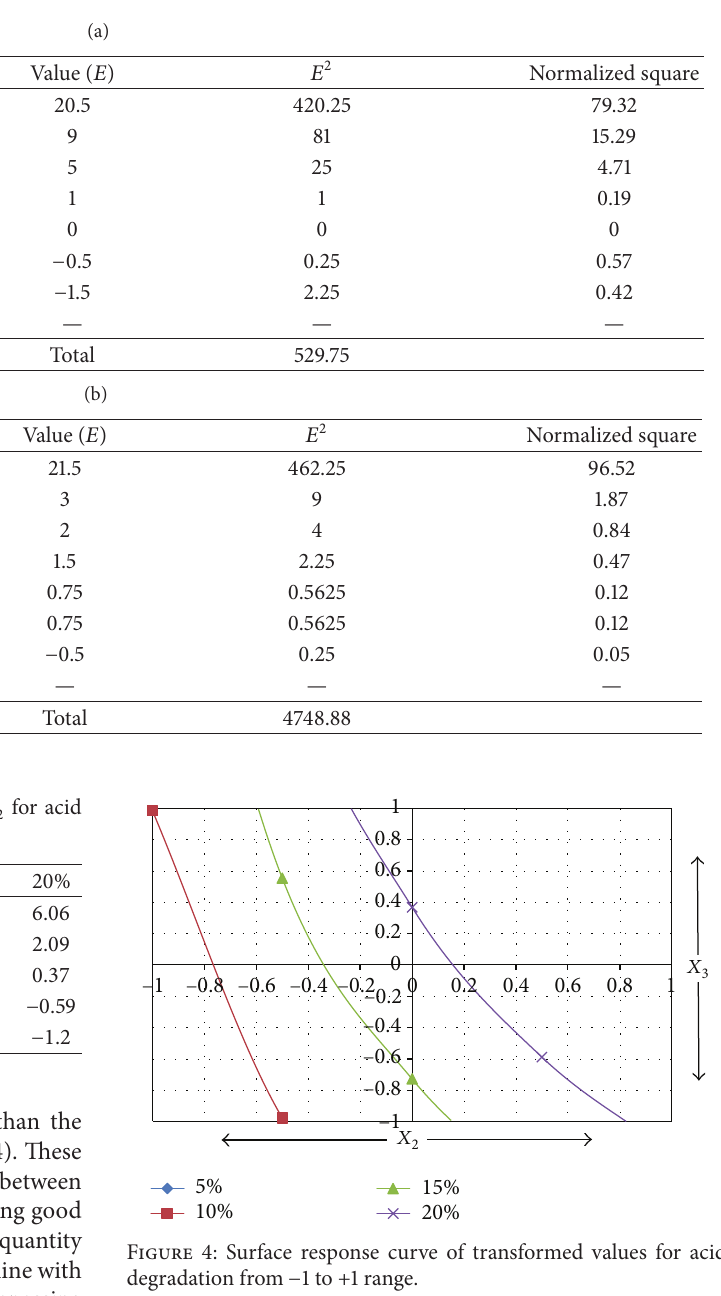
Table 3: (a) Normalized square values for acid degradation. (b) Normalized square values for alkali degradation.